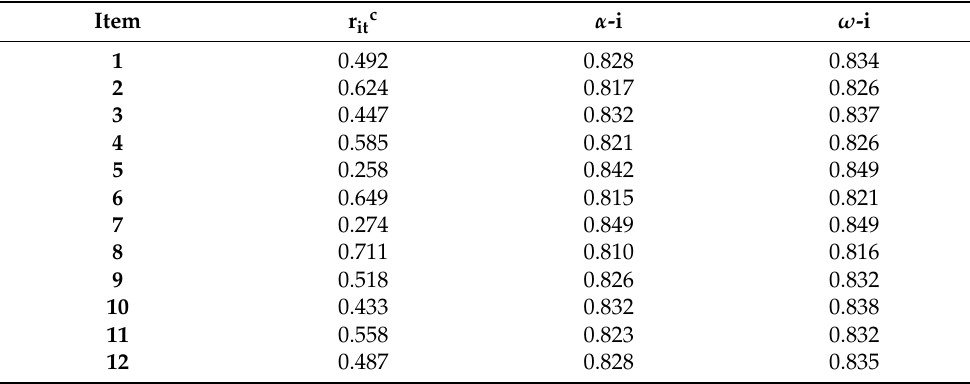
Table 3. Psychometric characteristics of the Spanish version of the HSC scale.